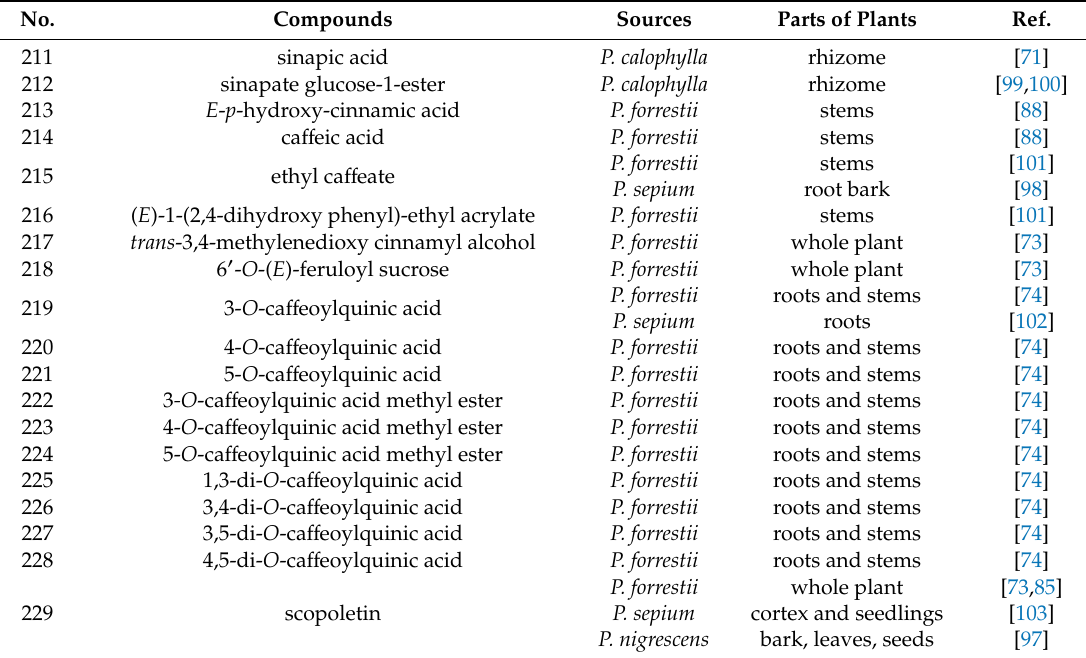
Table 5. Phenylpropanoids from the genus Periploca